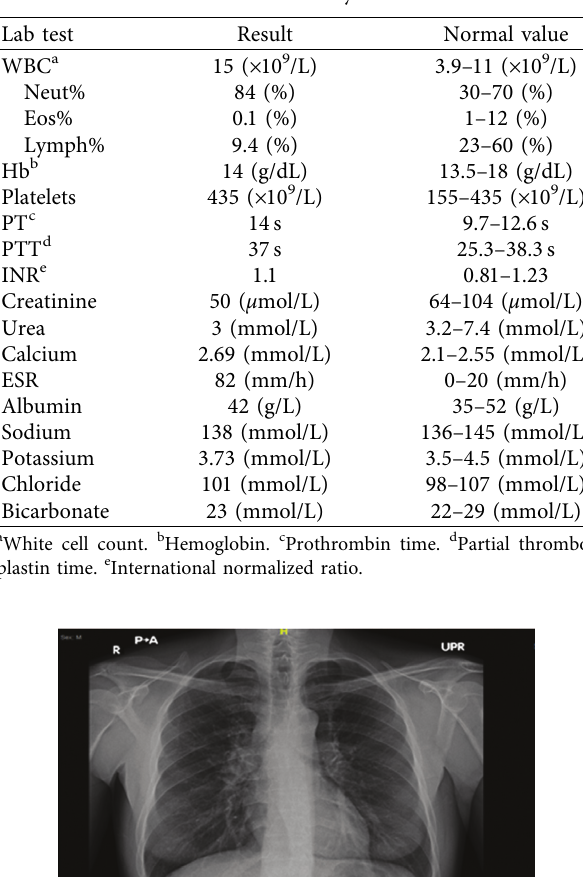
Table 1: Laboratory results.